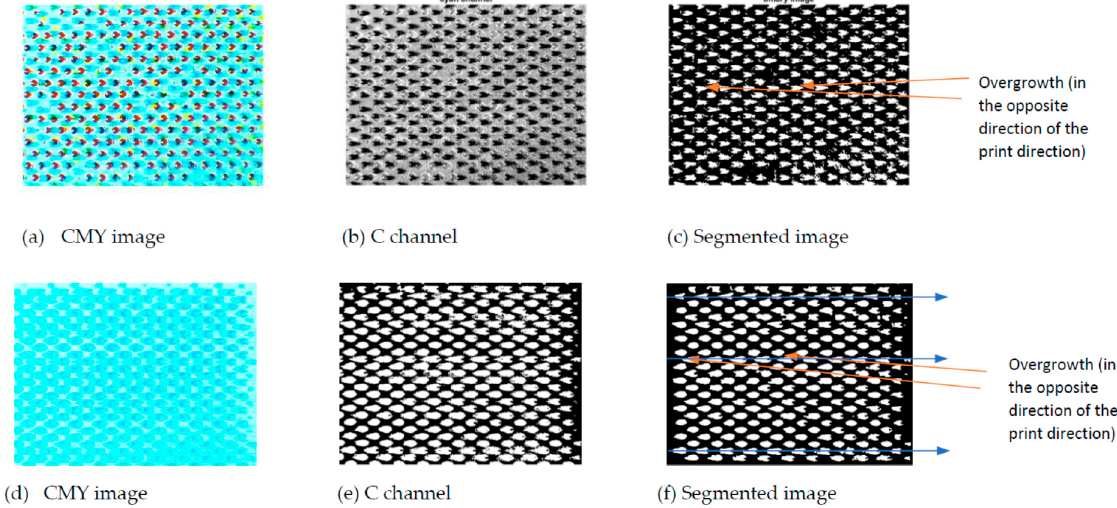
Figure 17. Examples of dot deformation.